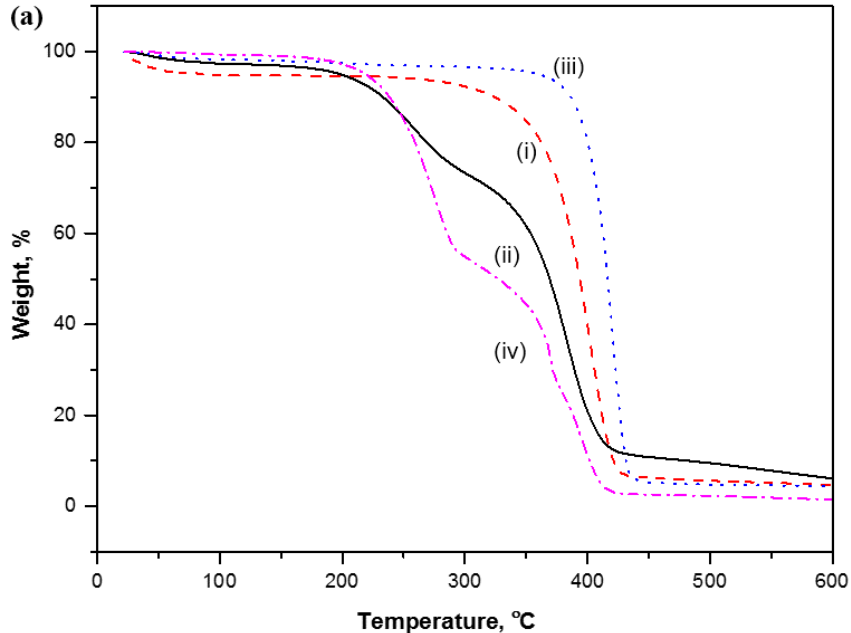
Figure 2. Thermogravimetric analysis representing ( a ) weight loss; ( b ) differential weight loss of (i) unmodified microfibrillated cellulose (MFC); (ii) modified MFC; (iii) pure styrene-maleimide (SMI) and (iv)